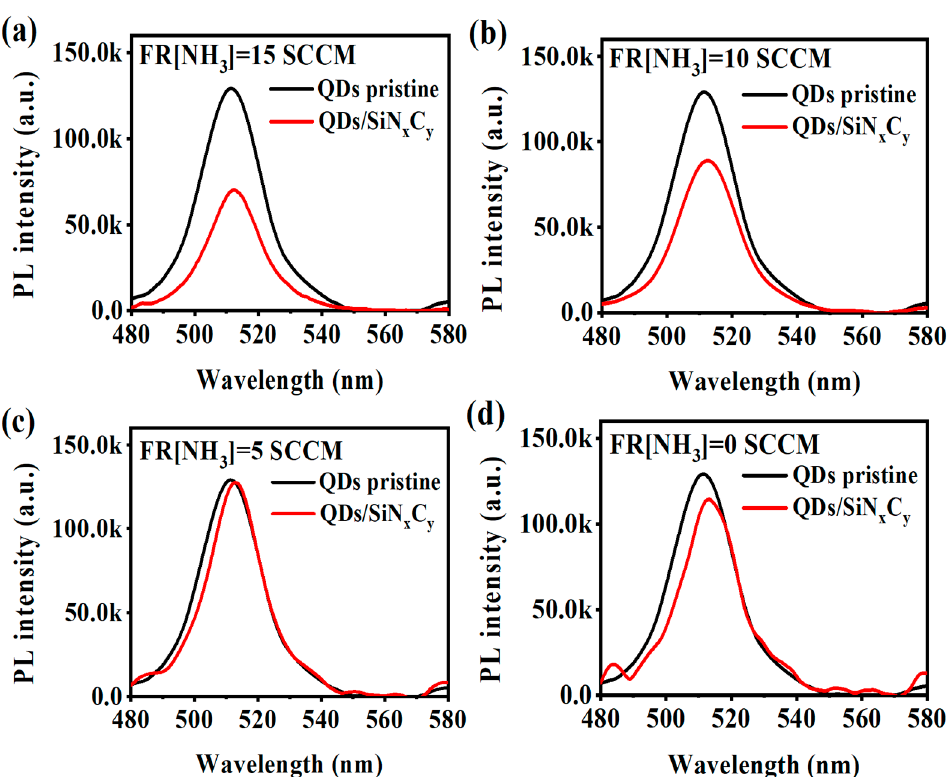
Figure 2. PL spectra acquired from the pristine CsPbBr 3 QD film and CsPbBr 3 QDs/a-SiC x N y :H nanocomposite thin films prepared with different NH 3 flow rates: ( a ) 15 SCCM; ( b ) 10 SCCM; ( c ) 5 SCCM; ( d ) 0 SCCM, respectively.